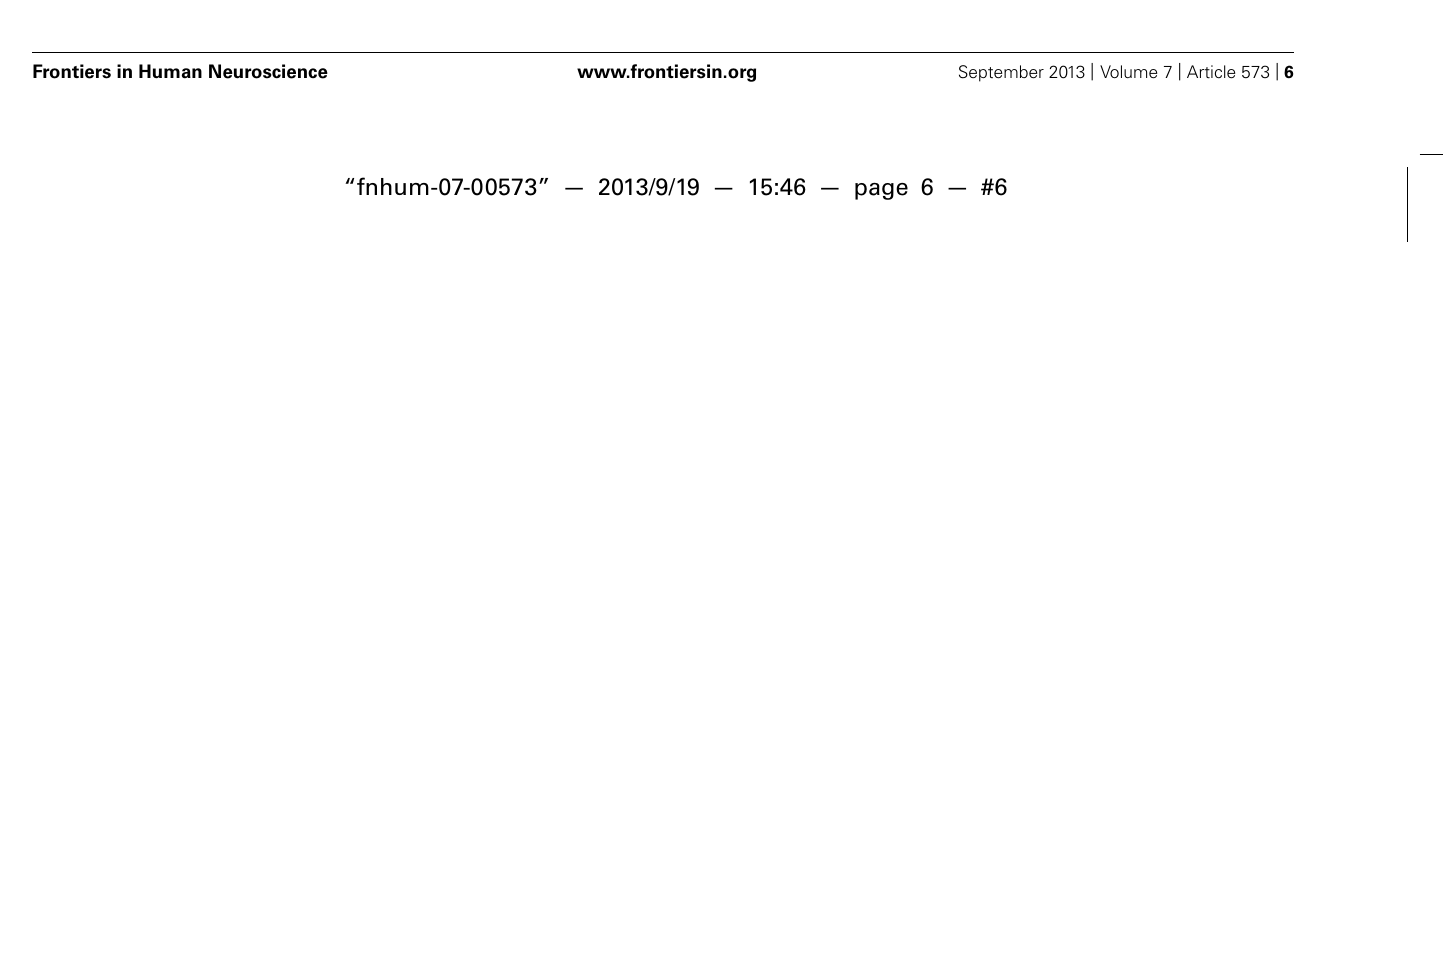
seed in the ASD than NT group (yellow) which was the medial prefrontal cortex.The NT group showed greater connectivity between the RLatP seed and regions within the cerebellum (blue) than the ASD group. All maps are thresholded at p < 0.001, FWE cluster corrected at p <